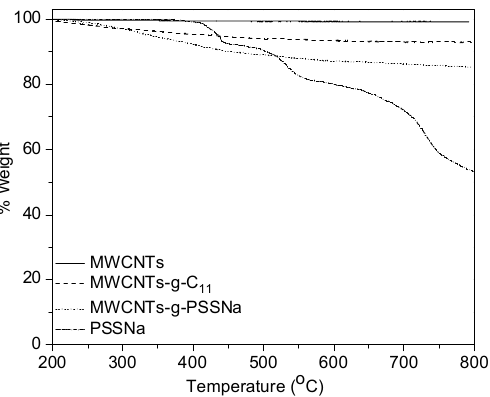
Figure 3. TGA analysis of pristine MWCNTs and MWCNTs functionalized with the undecyl groups (MWCNTs-C 11 ) and the sodium styrene sulfonate monomer (MWCNTs- g -PSSNa).